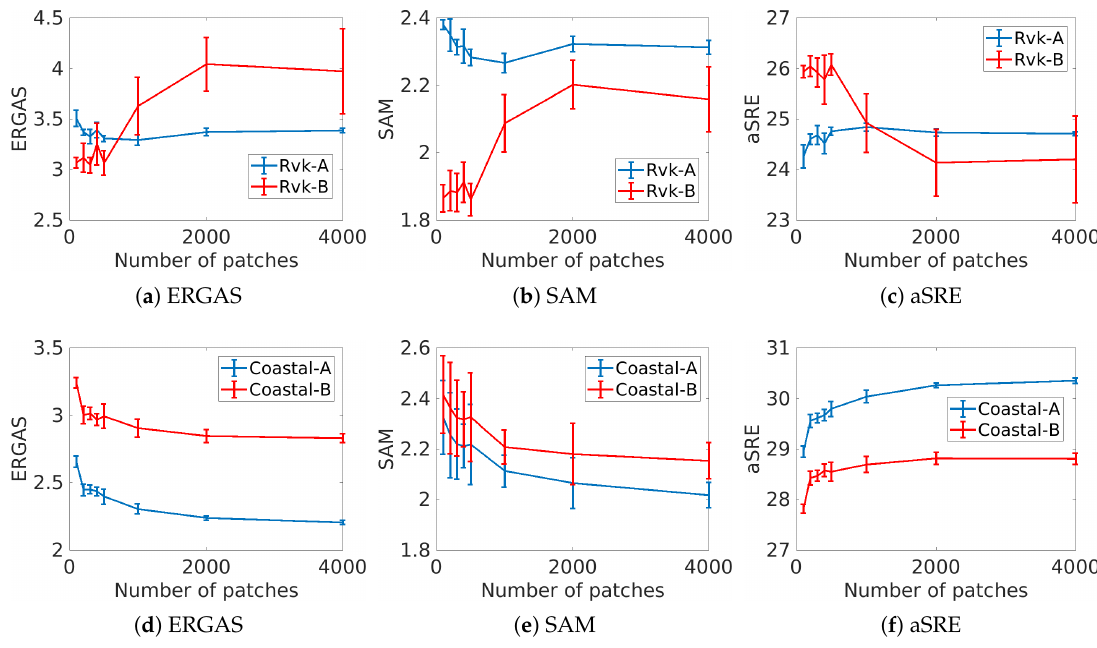
Figure 5. Values of the quality evaluation metrics as a function of the number of training patches for the Coastal and urban Rvk datasets. The network was trained on the A image and tested on A and B. aSRE is the average SRE of the bands and is given in dB and SAM is given in